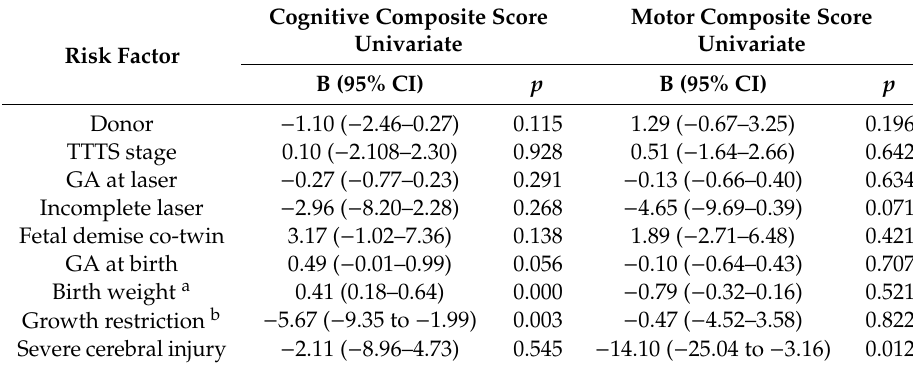
Table 3. Association of potential risk factors with cognitive and motor composite